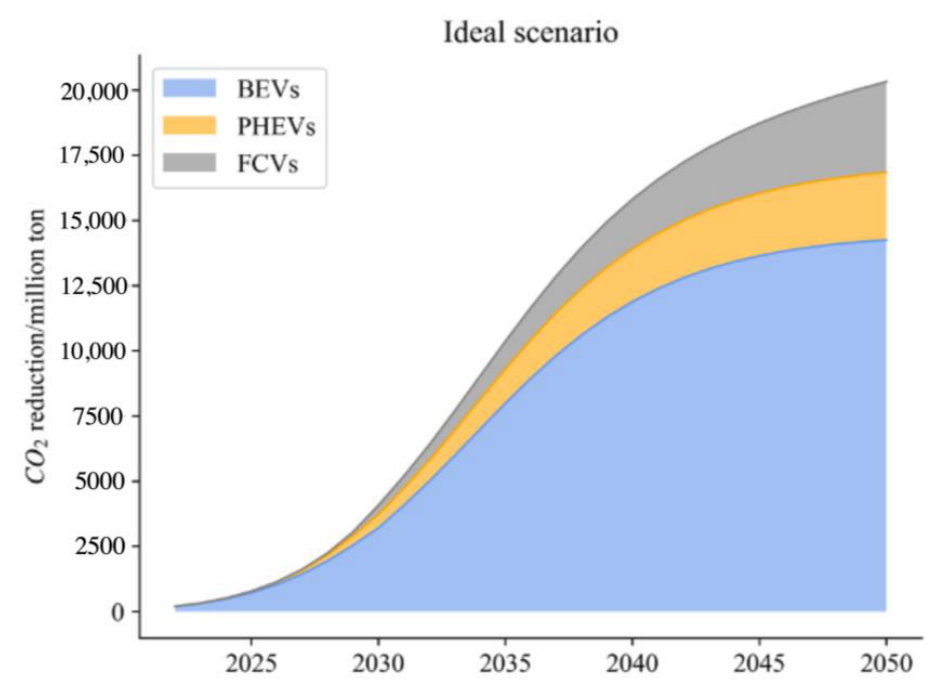
Figure 5. Carbon reduction under the ideal scenario.